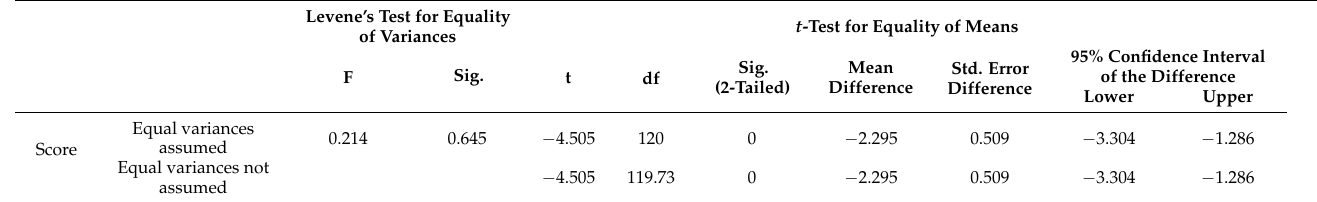
Table 1. Independent Samples of